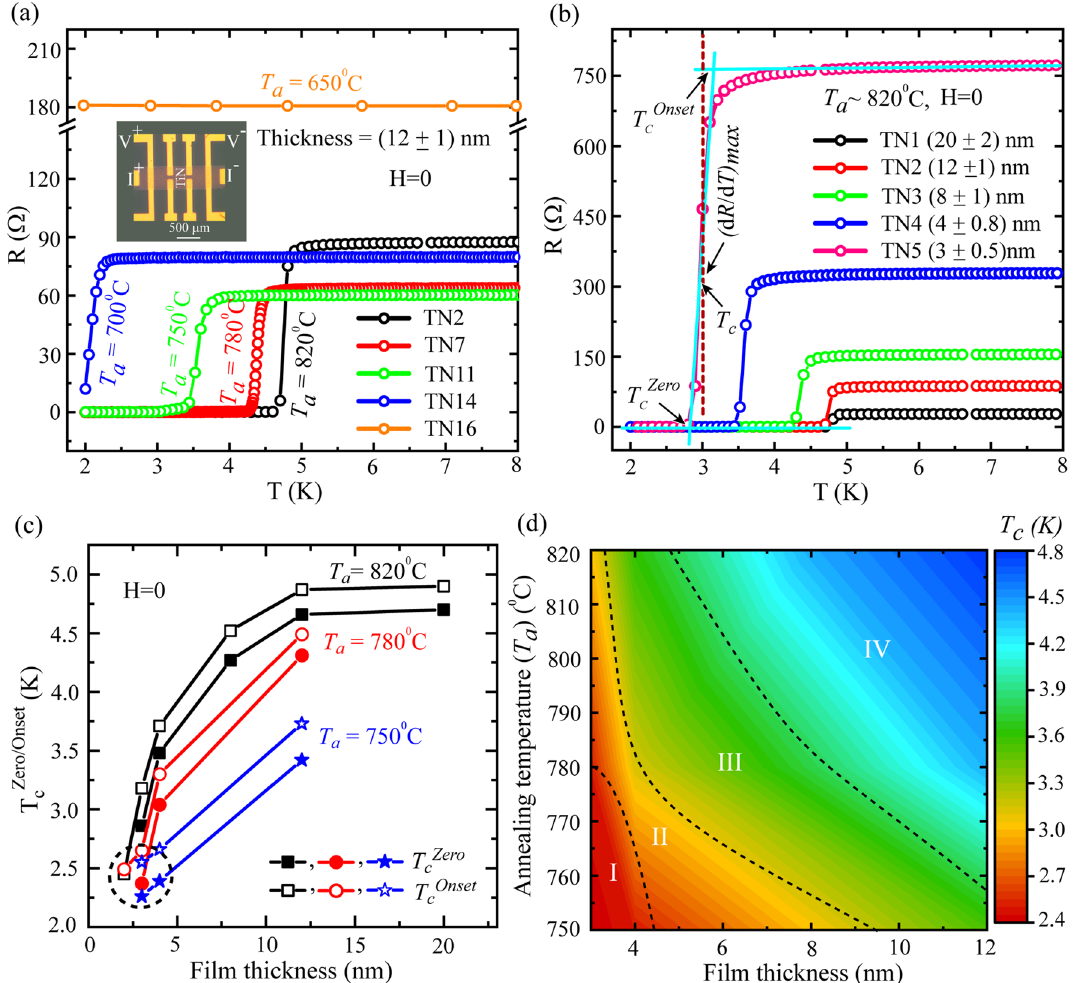
Figure 1. Superconducting properties probed by temperature dependent resistance R(T) measurements. ( a ) A set of R(T ) measurements done on TiN thin films grown at varying annealing temperature ( T a ) while keeping the thickness same of about 12 nm. Inset: Optical microscopy image of a representative multiterminal device showing the measurement scheme for tranport measurements in four probe geometry. ( b ) A different set of R(T) measured on samples with varying thickness but annealed at same temperature, T a = 820 °C. Different critical temperatures, ( T c Onset , T c Zero and T c ), are defined as shown in ( b ) for the representative curve with thickness around 3 nm. ( c ) Thickness dependent T c values collected from the samples annealed at T a = 820 °C, 780 °C and 750 °C. ( d ) A contour color plot representation of the summary related to the dependence of critical temperature ( T c ) on thickness and annealing temperature ( T a ). Different regions are marked by Roman numerals and are bounded by the dashed boundary